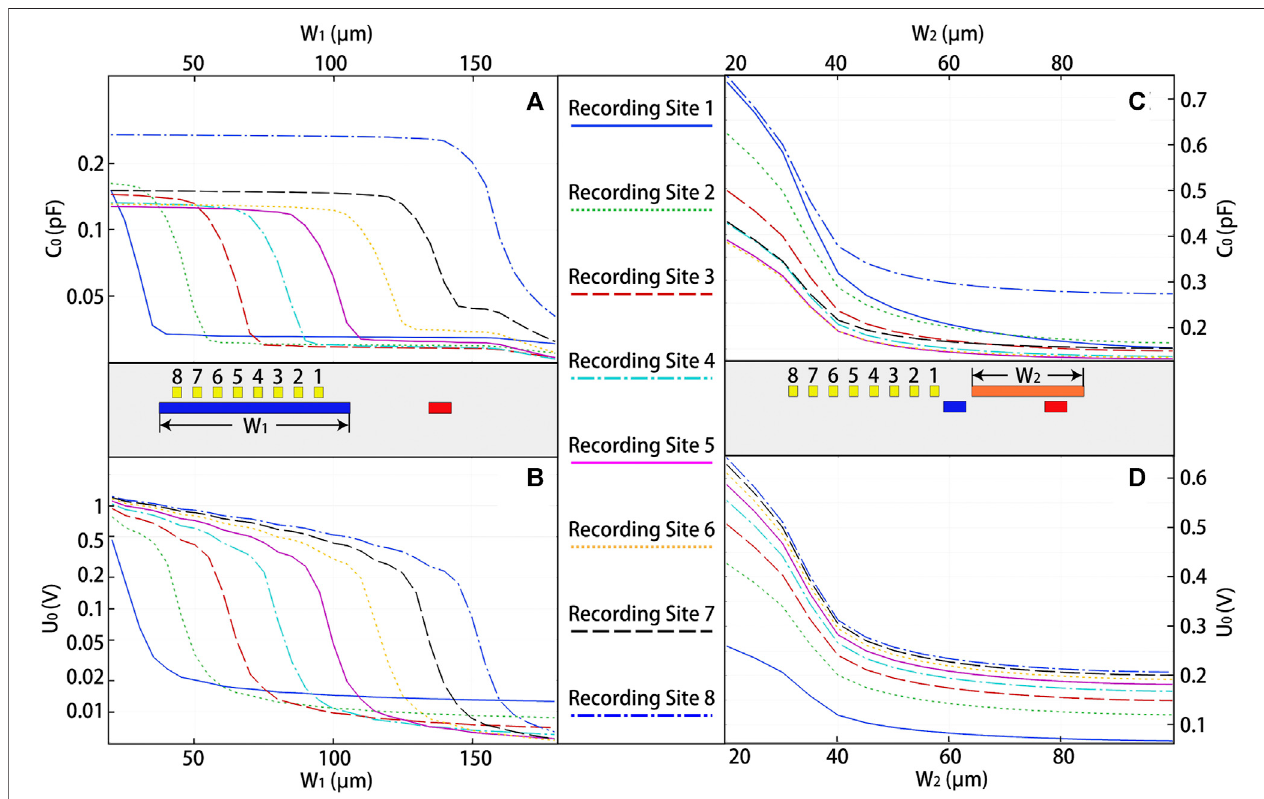
FIGURE 7 | The relationship between (A) the coupling capacitance and the width of the cathode, (B) the spatial potential and the width of the cathode, (C) the coupling capacitance and the width of anode shielding metal, (D) the spatial potential and the width of anode shielding metal for eight recording electrodes.